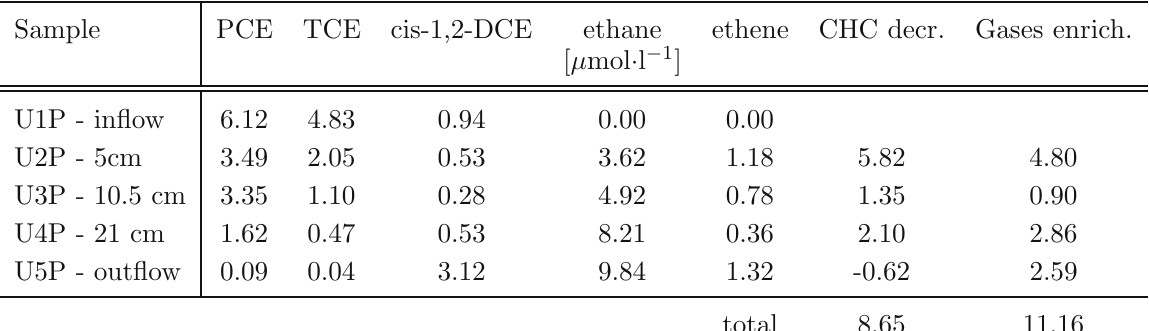
Table 2 The balance between degradation of sequential chlorinated solvents and enrich- ment of water by ethane and